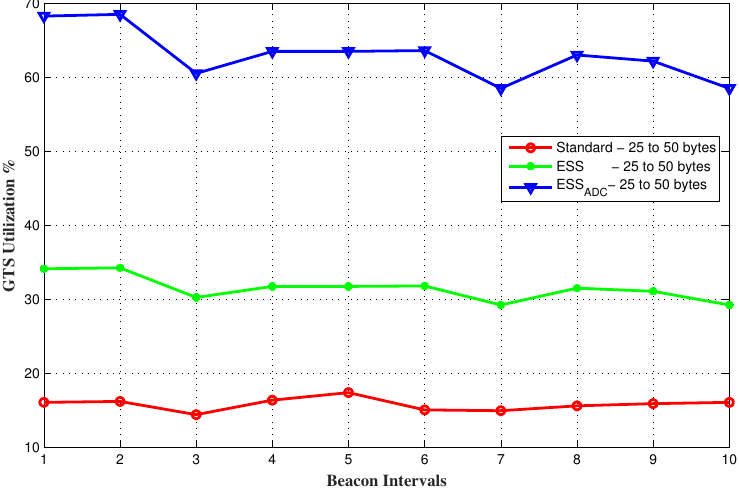
Figure 8. GTS utilization of the network for random data requesting